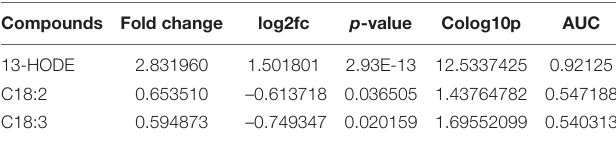
TABLE 5 | Statistically significant compounds (O vs., L). P -value < 0.05 (Wilcoxon-Mann-Whitney test). Fold change ≥ 1.5 or ≤ 1/1.5. AUC (area under the curve) value of predictors selected by machine learning analysis (see Supplementary Figures 12–14 A–C and Supplementary Tables 1, 5 ). Compounds Fold change